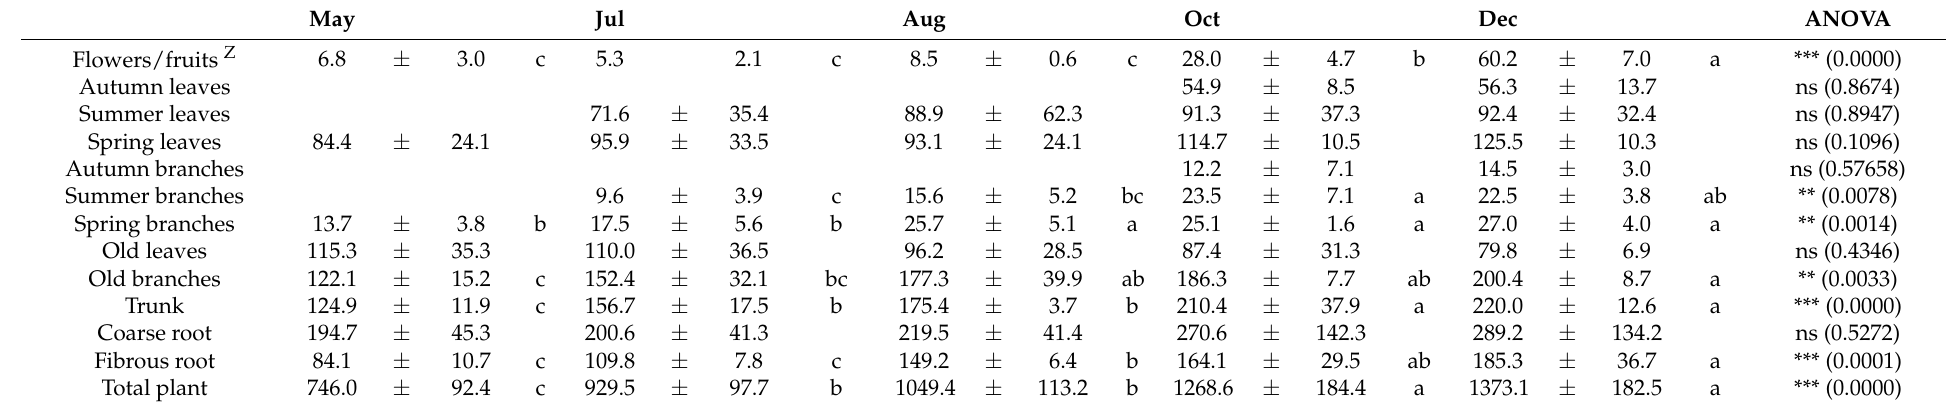
Table 1. Dry-biomass (g, DW plant − 1 ) partitioning among the main organs of Nules clementine trees uprooted in May (flowering), July (fruit set and the end of fruit drop), August (fruit growth), October (fruit growth), and December (fruit maturity). Values are means ± SD (n = 4). Different lowercase letters indicate significant differences based on one-way analysis of variance. Significant effects of the Fe dose applied are given at p ≤ 0.01 (**), p ≤ 0.001 (***), and ns (not significance) at each plant component. p -value between brackets (LSD test). DW: dry